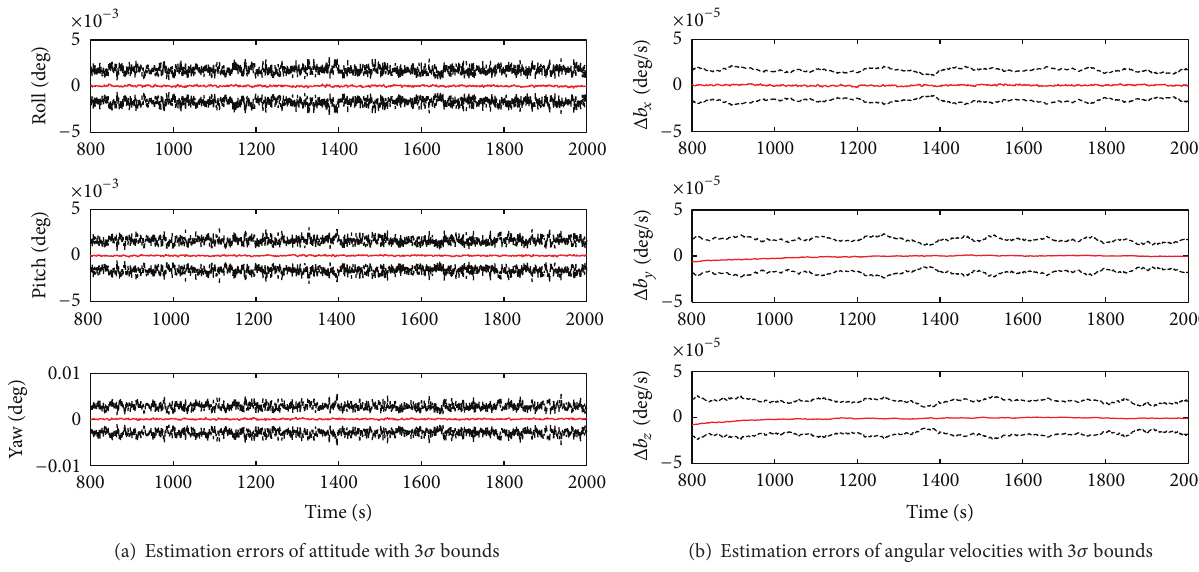
(a) Estimation errors of attitude with 3𝜎 bounds (b) Estimation errors of angular velocities with 3𝜎 bounds Figure 4: Estimation errors with 3𝜎 bounds in the attitude